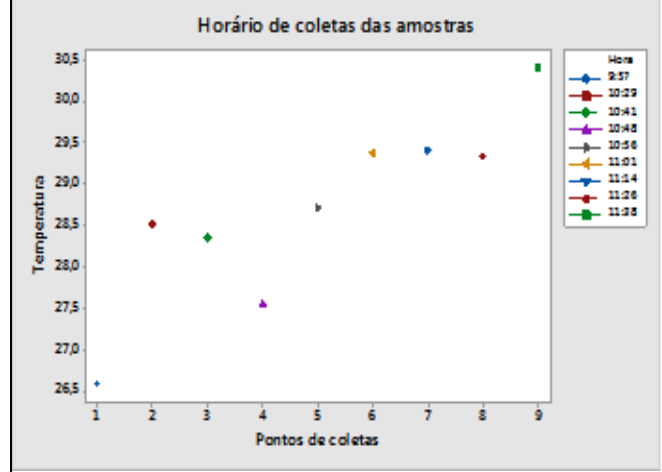
Figura 11: Temperatura em cada ponto coletado Fonte: Autores,